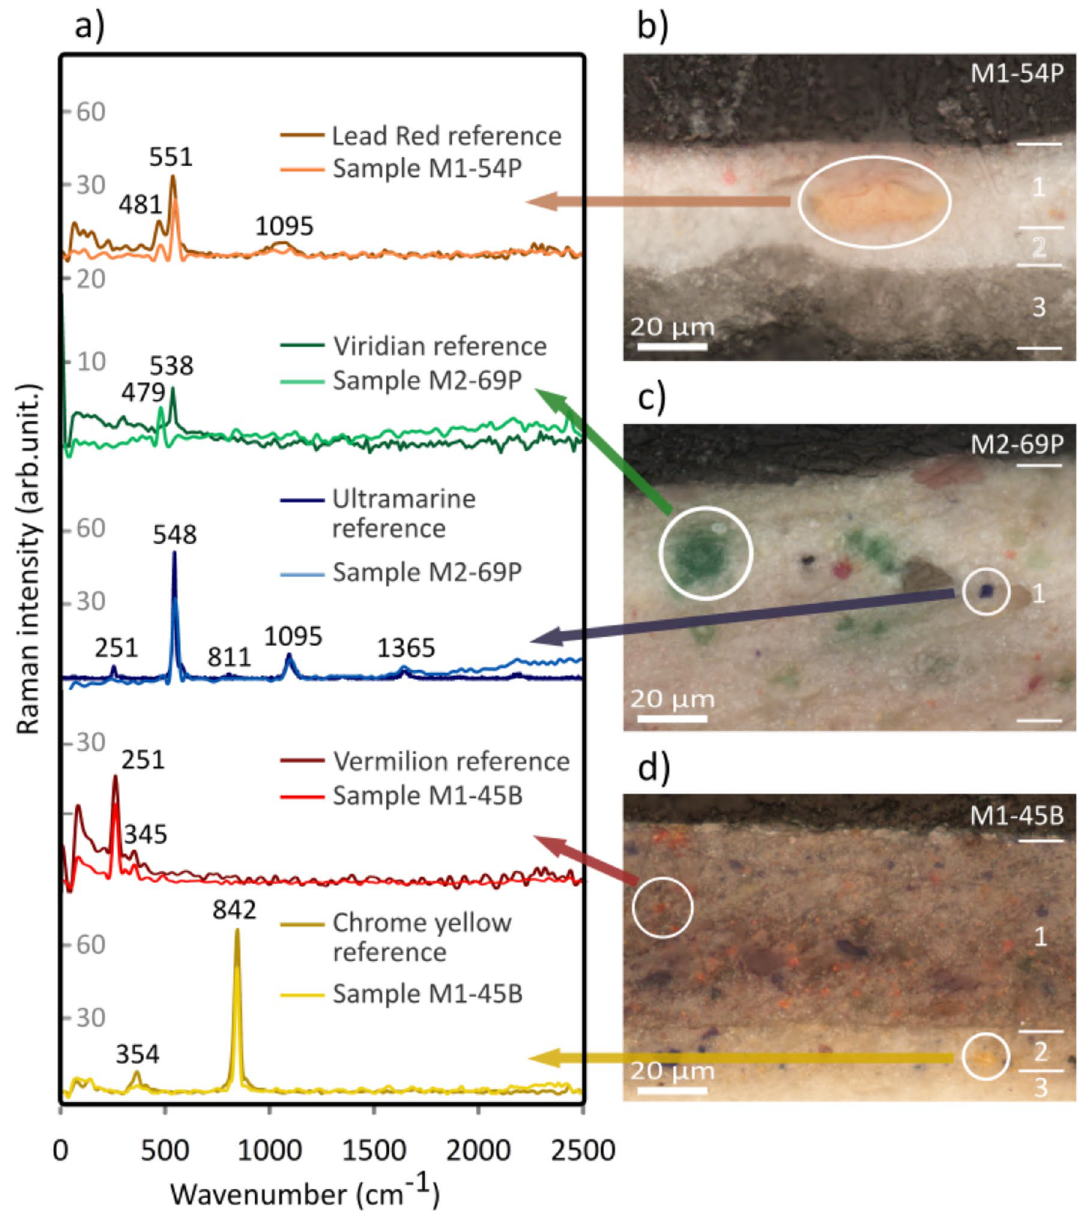
Figure 6. In low frequency: Raman spectroscopy of the pigments. ( a ) Comparison of Raman spectra for reference pigments and those of the samples. ( b ) Orangey–pink crystal from sample M1-54P corresponds to lead red, ( c ) Green and blue crystals from sample M2-69P correspond to viridian and ultramarine, respectively. ( d ) Red and yellow crystals from sample M1-45B correspond to vermilion and chrome yellow,